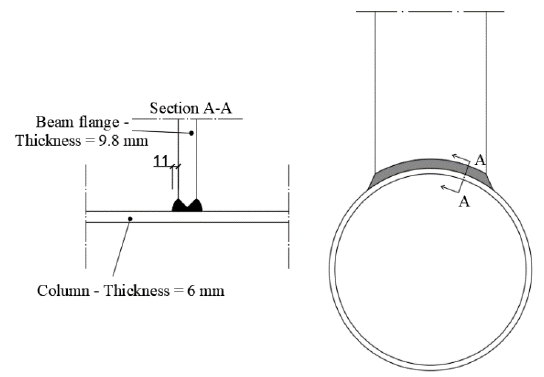
Figure 2. Welding Figure 2. Welding detail.